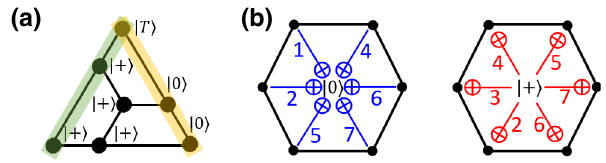
FIG. 21. T -state initialization for the 2D color code with dis- tance d = 3. (a) In step 1, the top qubit is prepared in | T (cid:2) , and the remaining data qubits are prepared in either |+(cid:2) or | 0 (cid:2) . We depict the support of logical X and Z representatives as shaded yellow and green strips. (b) In step 2, all the stabilizers are measured using the depicted CNOT order (or its restriction).